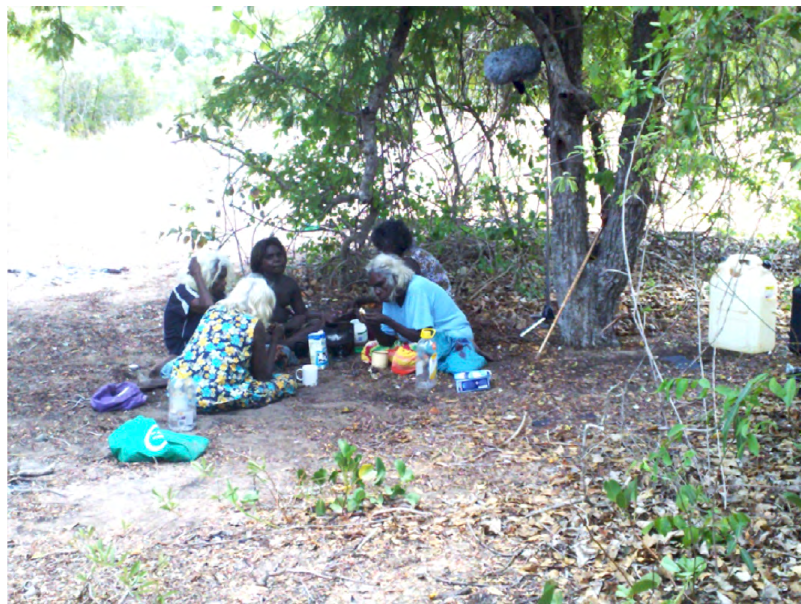
Figure 2: The “dead cat” windshield is perched above the speakers’ heads. Extract 13: Da Ngarne 20091121JBvid03_947645 ↓Da pilampi ngalla (ngurniwinart). (1.6) pungawuy.↓ da -winart pungam -wuy NC:PL/T salt_flat